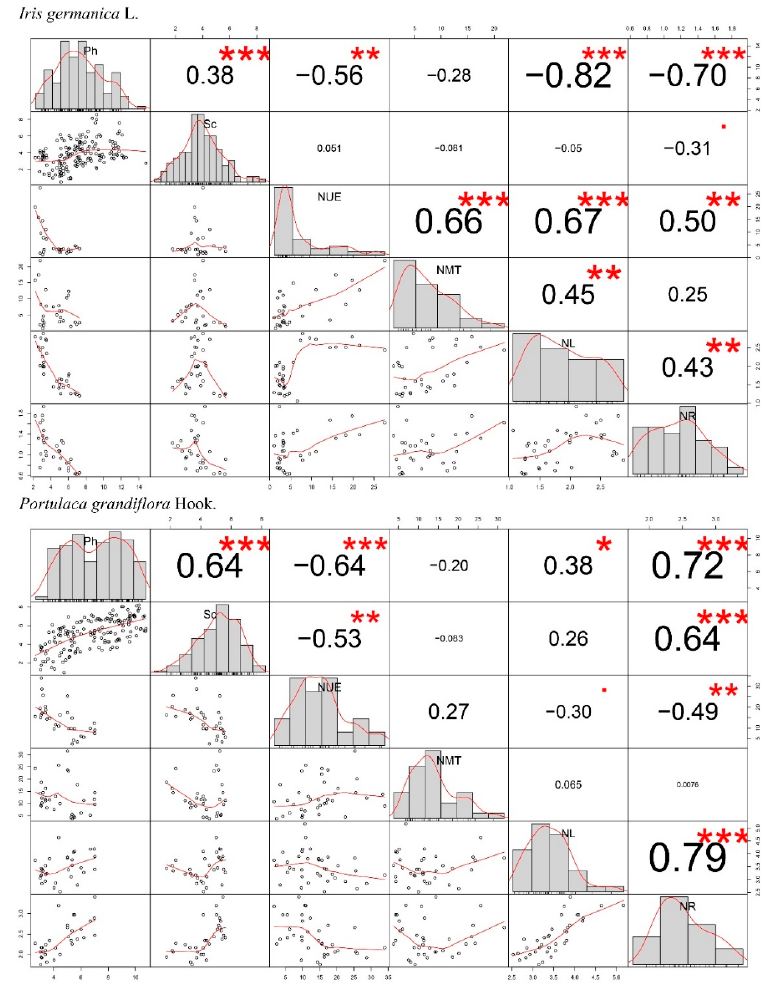
Figure 5. Pearson correlations between the net photosynthetic rate (Ph), stomatal conductance (g s ), the weight percentage of nitrogen (N) in the upper epidermis (UE), mesophyll tissue (MT), bulk of leaves (BL), and in the roots (R). At the bottom of the plot, bivariate scatter plots with a smooth line are displayed. At the top of the plot, the value of the correlation plus the significance level are displayed as asterisks (*** p < 0.001, ** p < 0.01, * p < 0.05). Units associated with the variables are shown in Figures 3 and